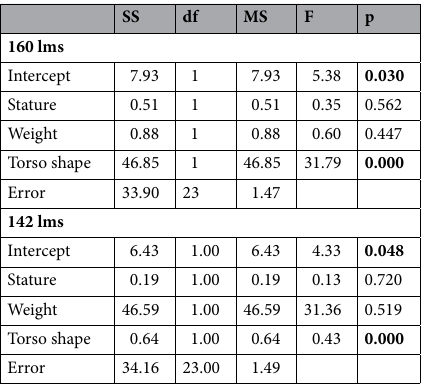
Table 5. Generalized Linear Models assessing the effects of stature, weight, torso shape (160 lms, 142 lms) on running performance. Significant values are in bold.